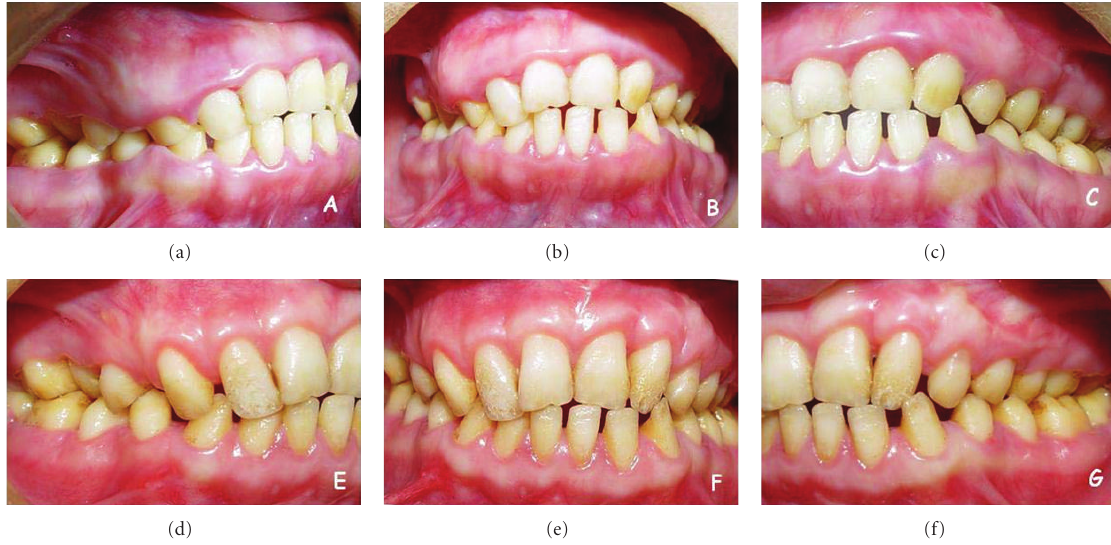
Figure 2: Initial appearance of 19-year-old patient presents more mild gingival enlargements comparing with her younger sibling ((a), (b), and (c)). Appropriate gingival form is constituted by periodontal flap surgery at the 3rd month before prosthetic treatment ((d), (e), and